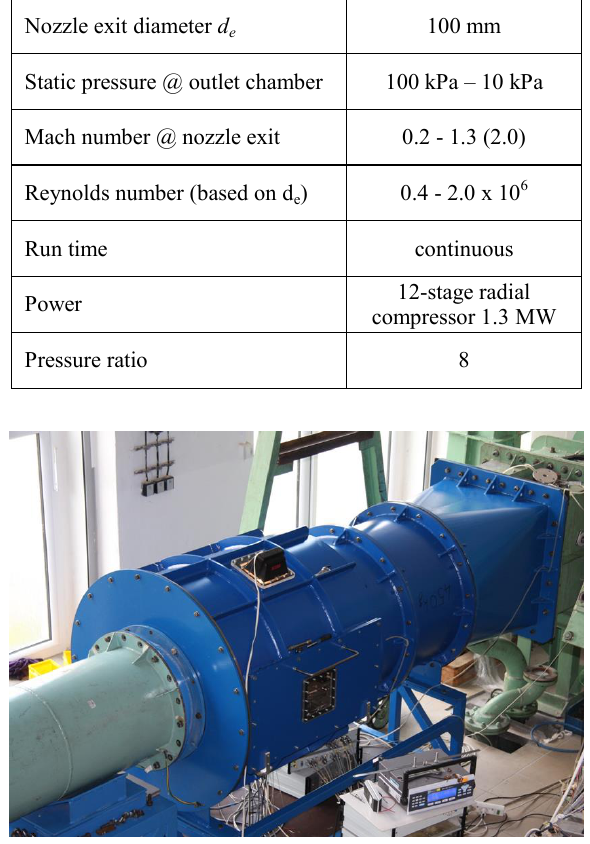
Fig. 2. The facility implemented to the wind tunnel